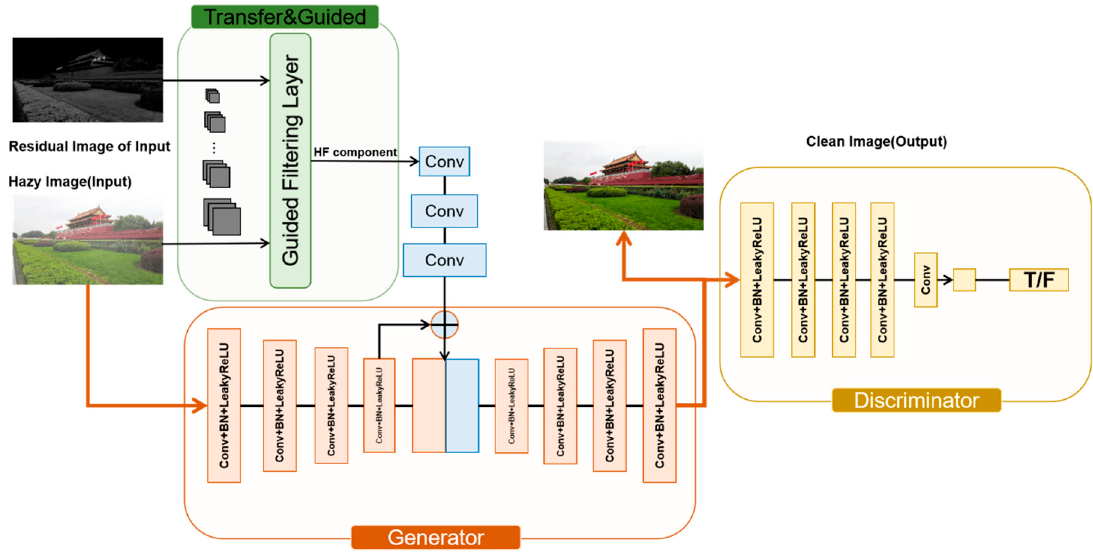
Figure 2. The architecture of the entire network.